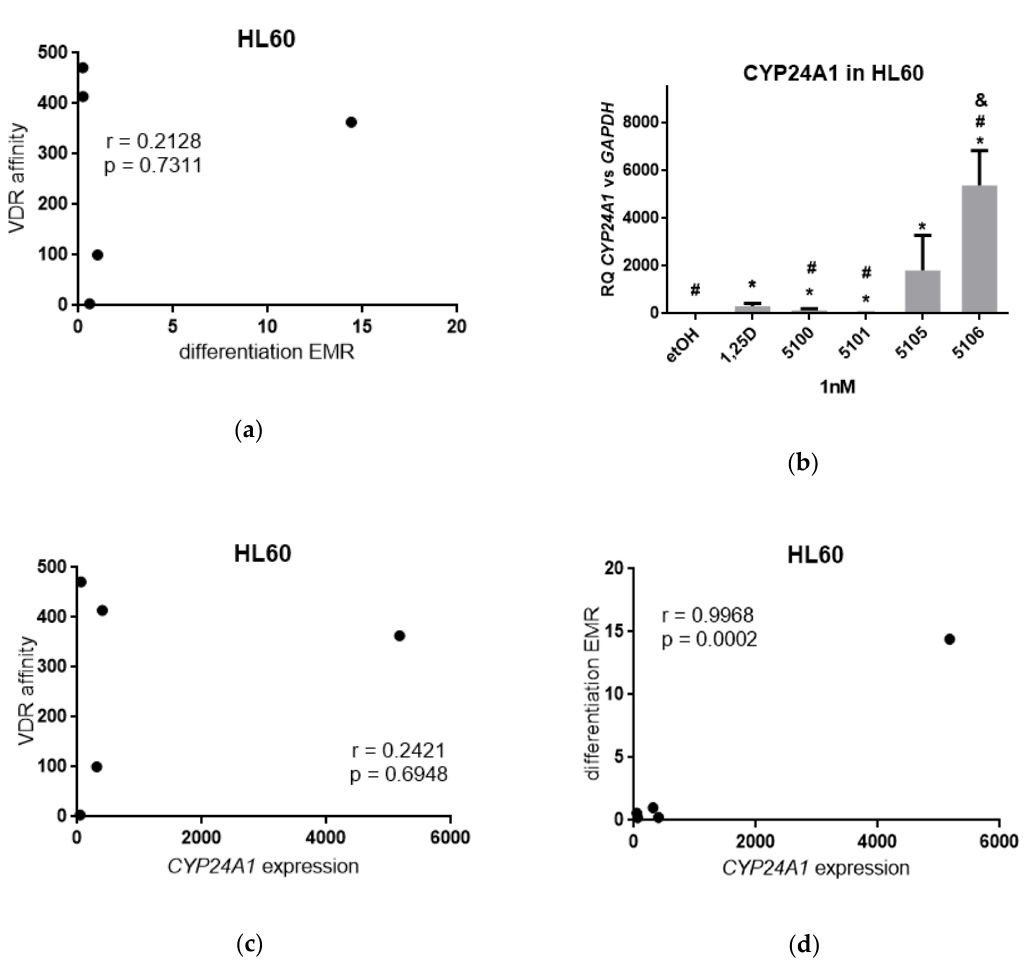
Figure 2. Activities of analogs towards HL60 cells. ( a ) Correlation between affinities of the analogs to VDR from Table 1 and their di ff erentiation-inducing activities from Table 2; ( b ) HL60 cells were exposed to 1 nM 1,25D3, or 1 nM analogs and after 96 h the expression of CYP24A1 mRNA was measured by real-time PCR. The bar charts show the mean values ( ± SD) of the fold changes in mRNA